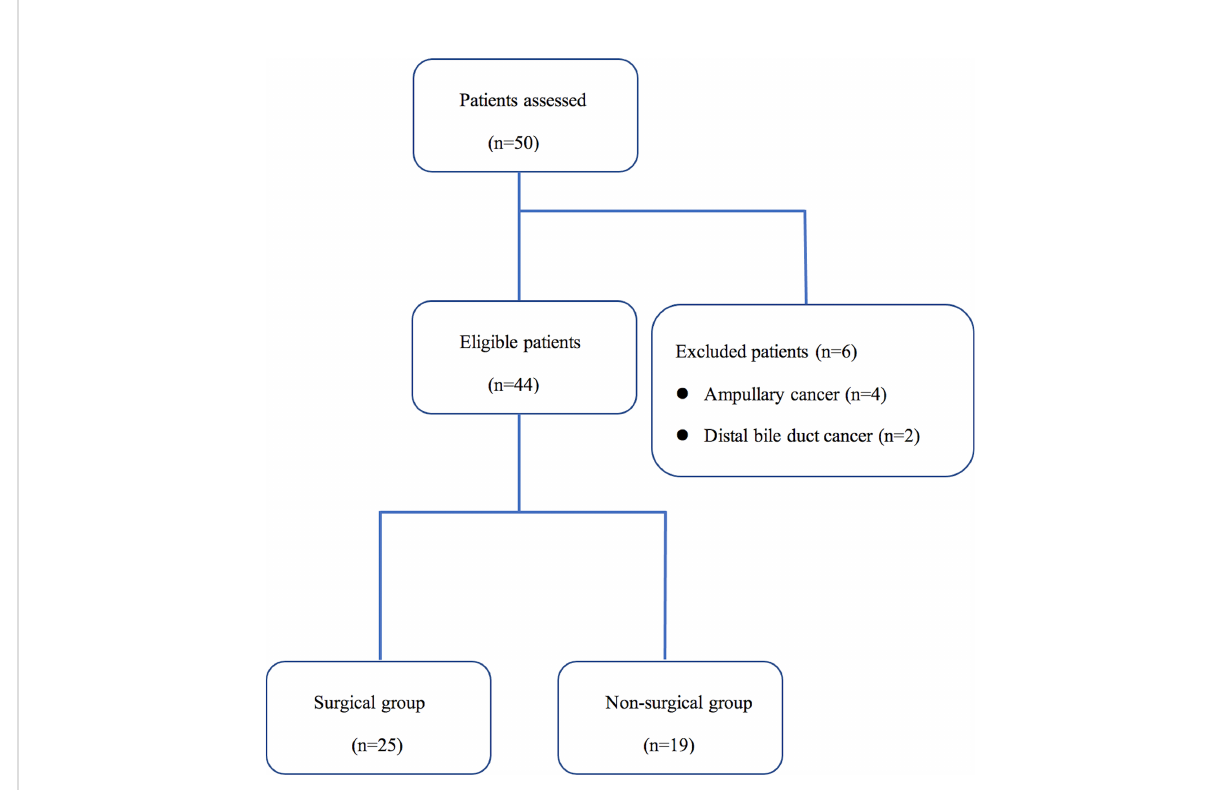
FIGURE 1 Flowchart of study cohort into 2 groups with different treatment